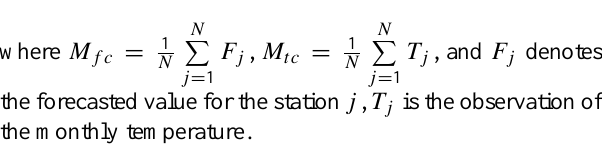
Figure 2. in ANGEO_05134